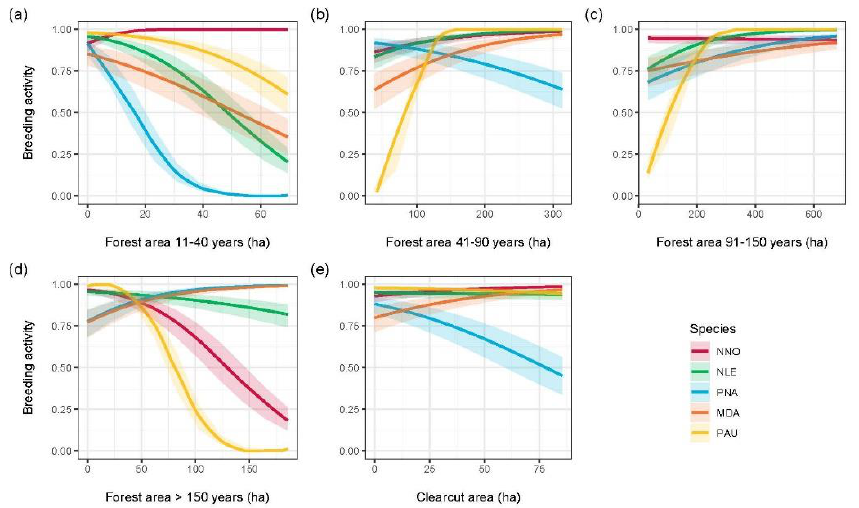
Figure 13. The probability of breeding activity of the five selected bat species as a function of the area of three forest age classes. See legend to Figure 12 for further details.